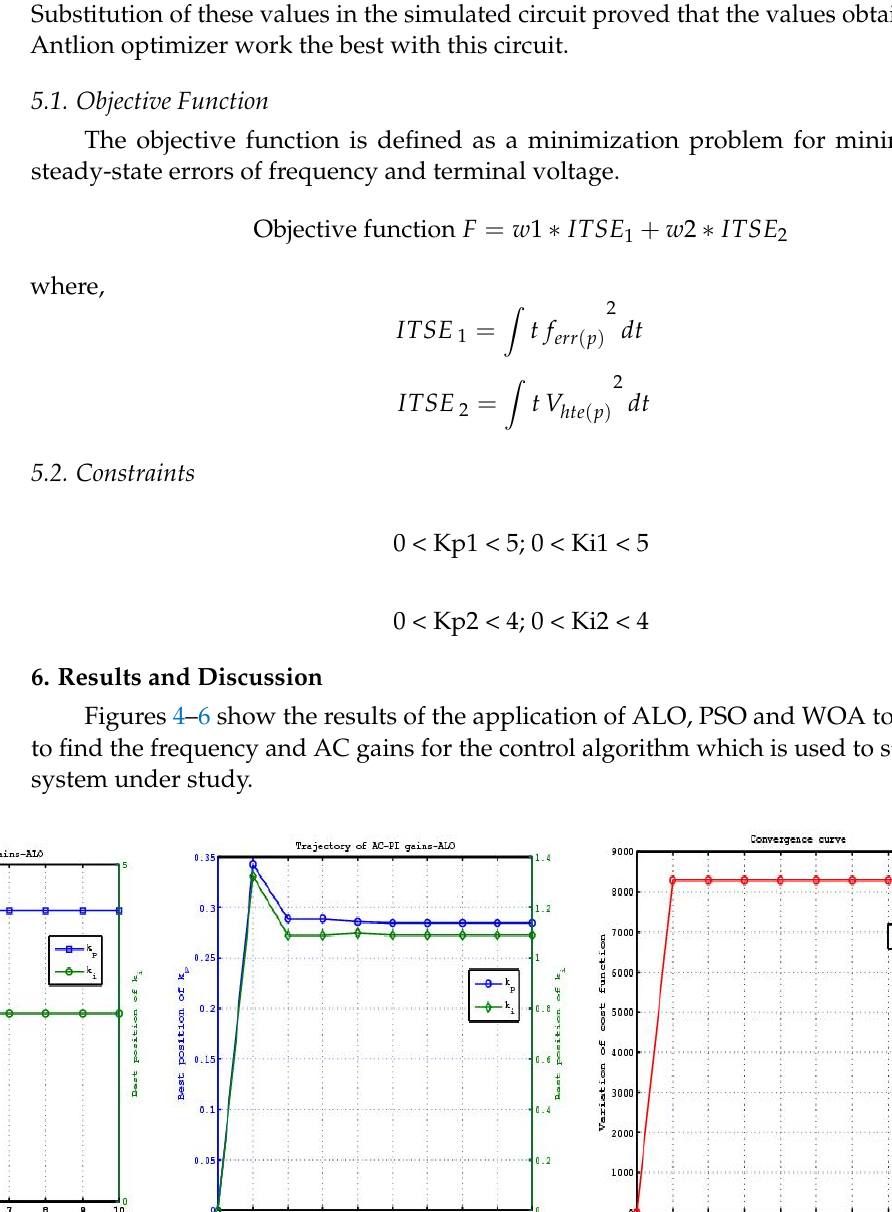
( c ) Figure 6. ( a ) Trajectory of frequency PI gain; ( b ) Trajectory of AC PI gain; ( c ) Convergence curve using Whale Optimization Algo- rithm (WOA).